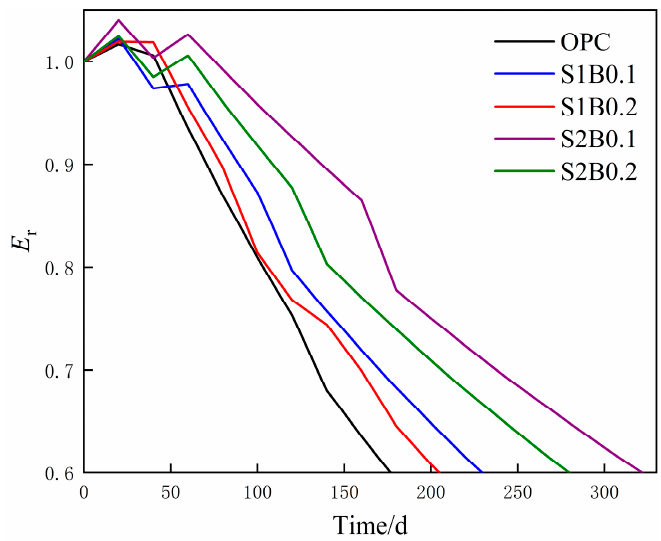
Figure 11. Remaining life curve of each group based on the GM(1,1)-Markov model.